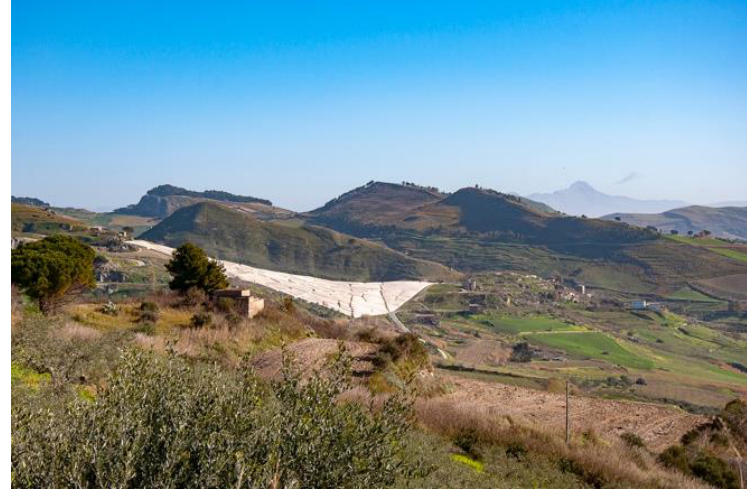
Figure 15. Cretto, project by Alberto Burri (1984 – 89, completed in 2015). Photo by the authors, Gibellina 2020.